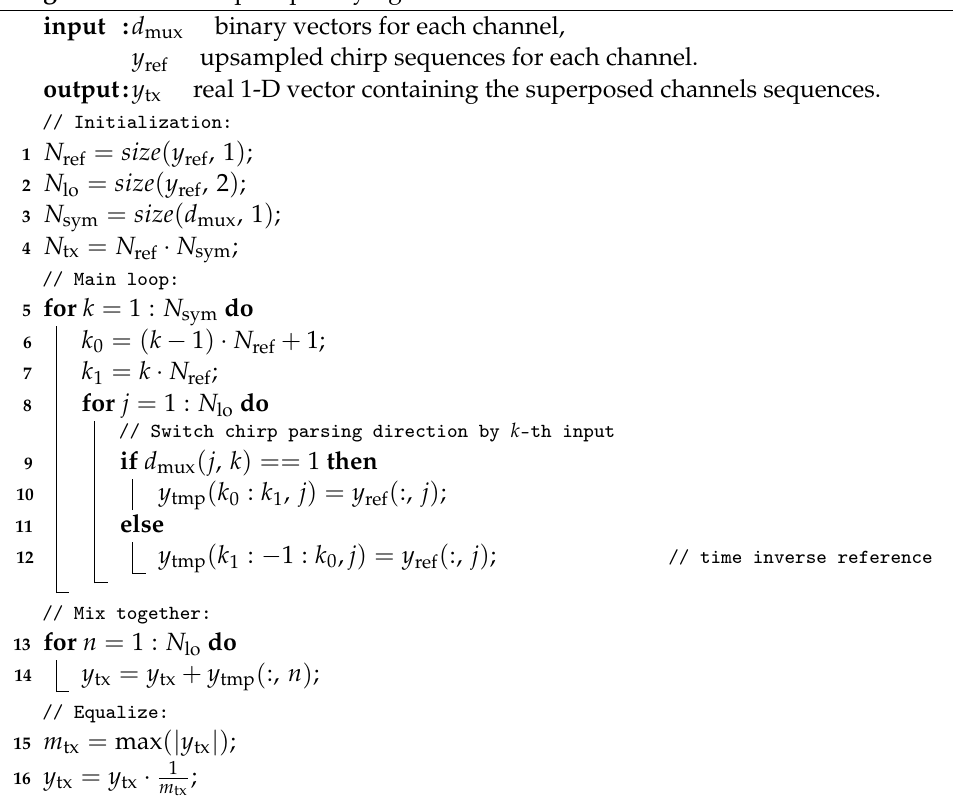
Algorithm A5: Chirp Slope Keying